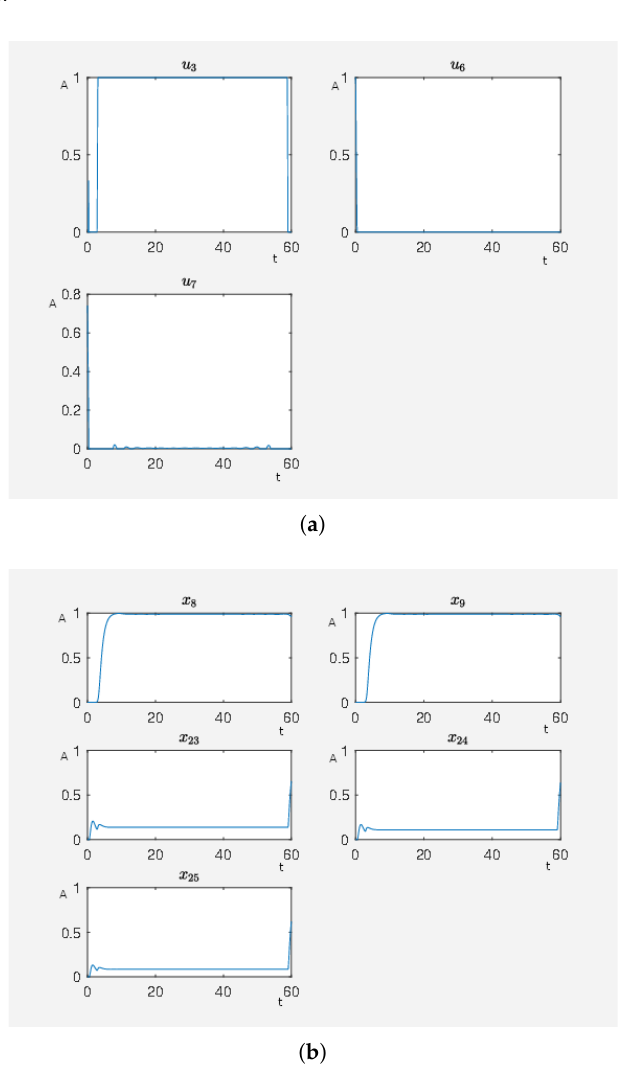
Figure 12. The optimal treatment strategy. ( a ) Time curve of external stimuli where u 3 inhibits ERK1/2 dim 3P, u 6 activates angiotensin II and u 7 activates isoproterenol. On the abscissa, we have the time (t) and on the ordinate the activity level (A). ( b ) Time curve of the nodes of interests where x 8 is the activity level of p90RSK, x 9 is the activity level of p70S6K, x 23 is the activity level of Elk1, x 24 is the activity level of MSK1 and x 25 is the activity level of c-Myc. On the abscissa, we have the time (t) and on the ordinate the activity level